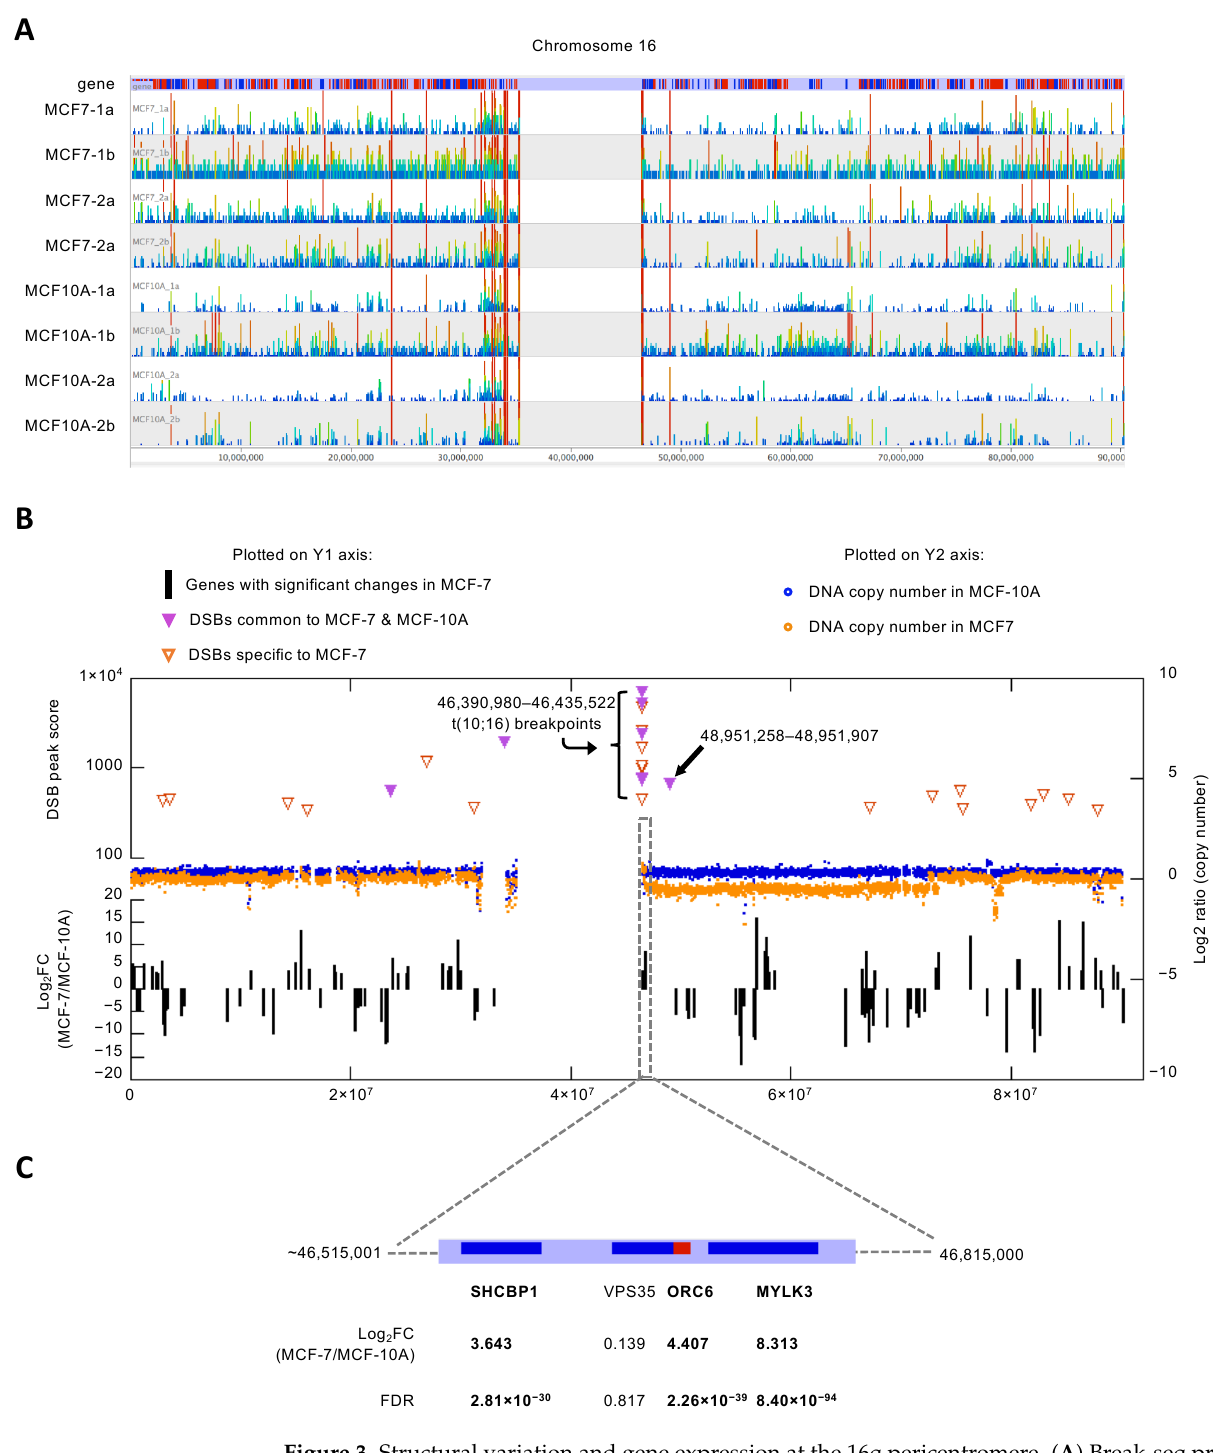
Figure 3. Structural variation and gene expression at the 16q pericentromere. ( A ) Break-seq profiles of all four replicate experiments in MCF-7 and MCF-10A cells on chr16. ( B ) Overlaid plots for DSB scores (top plot), DNA copy number (middle plot), and gene expression (bottom plot) for chr16. The DSB score and gene expression levels expressed as Log2 fold change (FC) in transcript level in MCF-7 over that in MCF-10A cells are plotted on the left, Y1, axis. The DNA copy numbers are plotted on the right, Y2, axis. ( C ) Expanded view of gene cluster immediately downstream of the pericentromeric region of 16q. FDR, false discovery